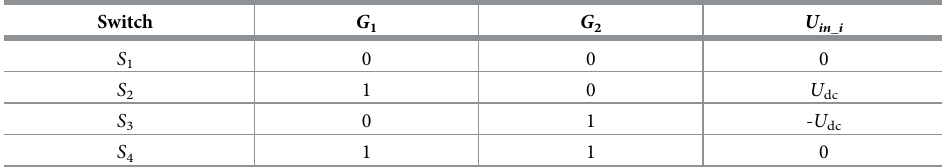
Table 1. Relationship between switching states and output voltage component.